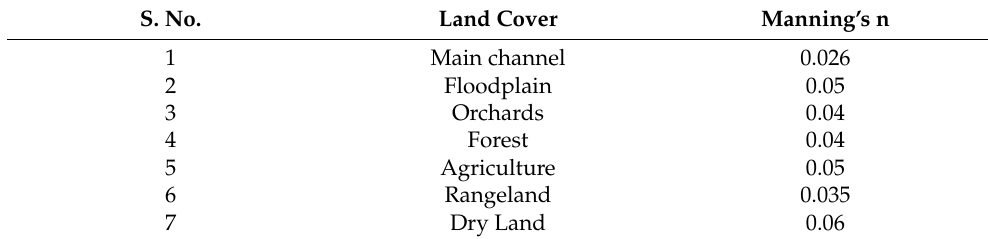
Table 1. Manning’s roughness coefficient values. S.